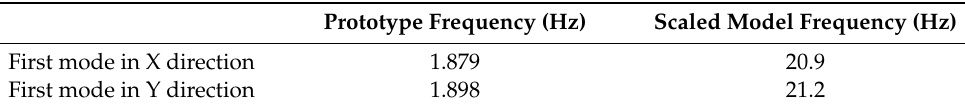
Table 3. Natural frequencies of towers.